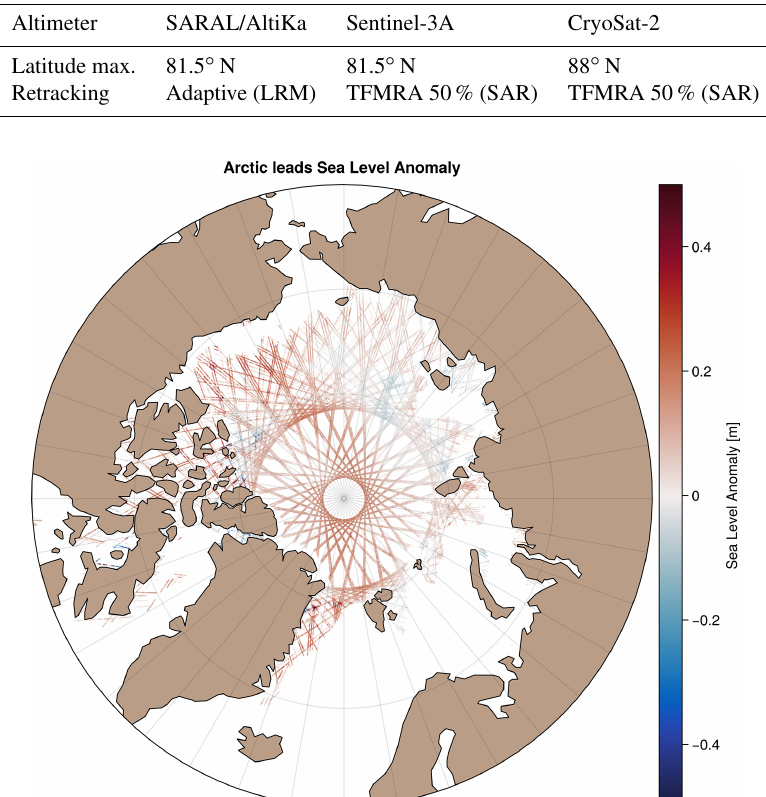
Figure 2. Example of Arctic leads’ sea-level altimetry coverage for a 7d period (from 1 July 2019 to 7 July 2019). Colour scale represents the sea-level anomaly amplitude in